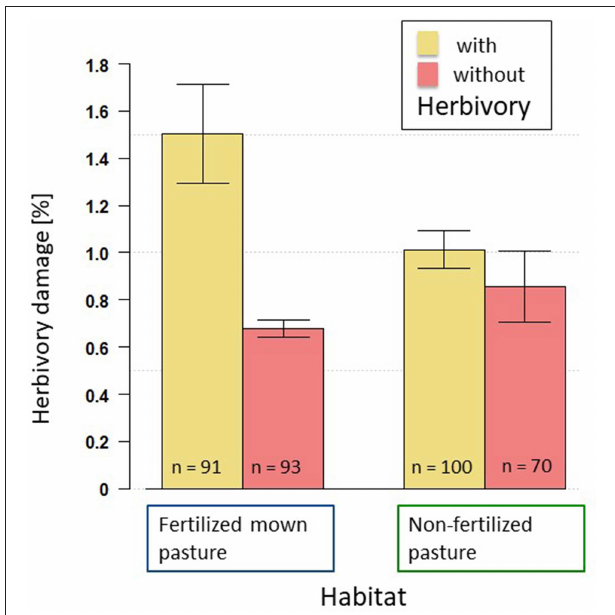
FIGURE 3 | Visually estimated damage by aboveground insect herbivores on experimental plants in the with-herbivory plots (yellow) and without-herbivory plots (orange) grown in fertilized mown pastures (left bars) and non-fertilized pastures (right bars).